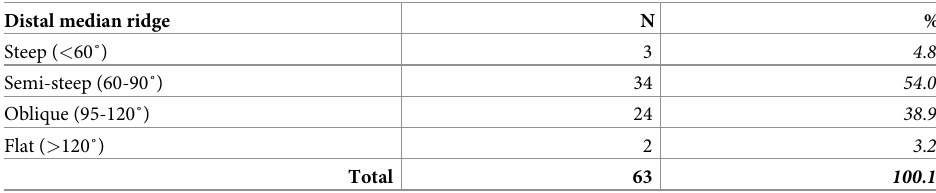
Table 6. Frequencies of distal median ridge angles on Tweefontein Nubian